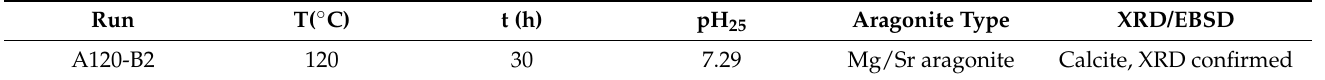
Figure 1. Teflon-lined autoclave. ( a ) Stainless steel body, ( b ) experimental design 1, ( c ) experimental design 2. The structure of the autoclave contains the following: (1) Teflon chamber, (2) sleeve body, (3) bottom disc, (4) rupture disc, (5) Lid, (6) locking screw, (7) synthetic aragonite powder placed at the bottom of the Teflon chamber, (8) brine level, (9) Teflon tube, and (10) aragonite powder placed in the Teflon tube. All experiments that were conducted at 120 ◦ , 150 ◦ , 162 ◦ , 180 ◦ , 184 ◦ C used design 1c. 52 * # at 250 ◦ C used design ( c ) and 03 & at 250 ◦ C used design ( b ). Table 1. Experimental